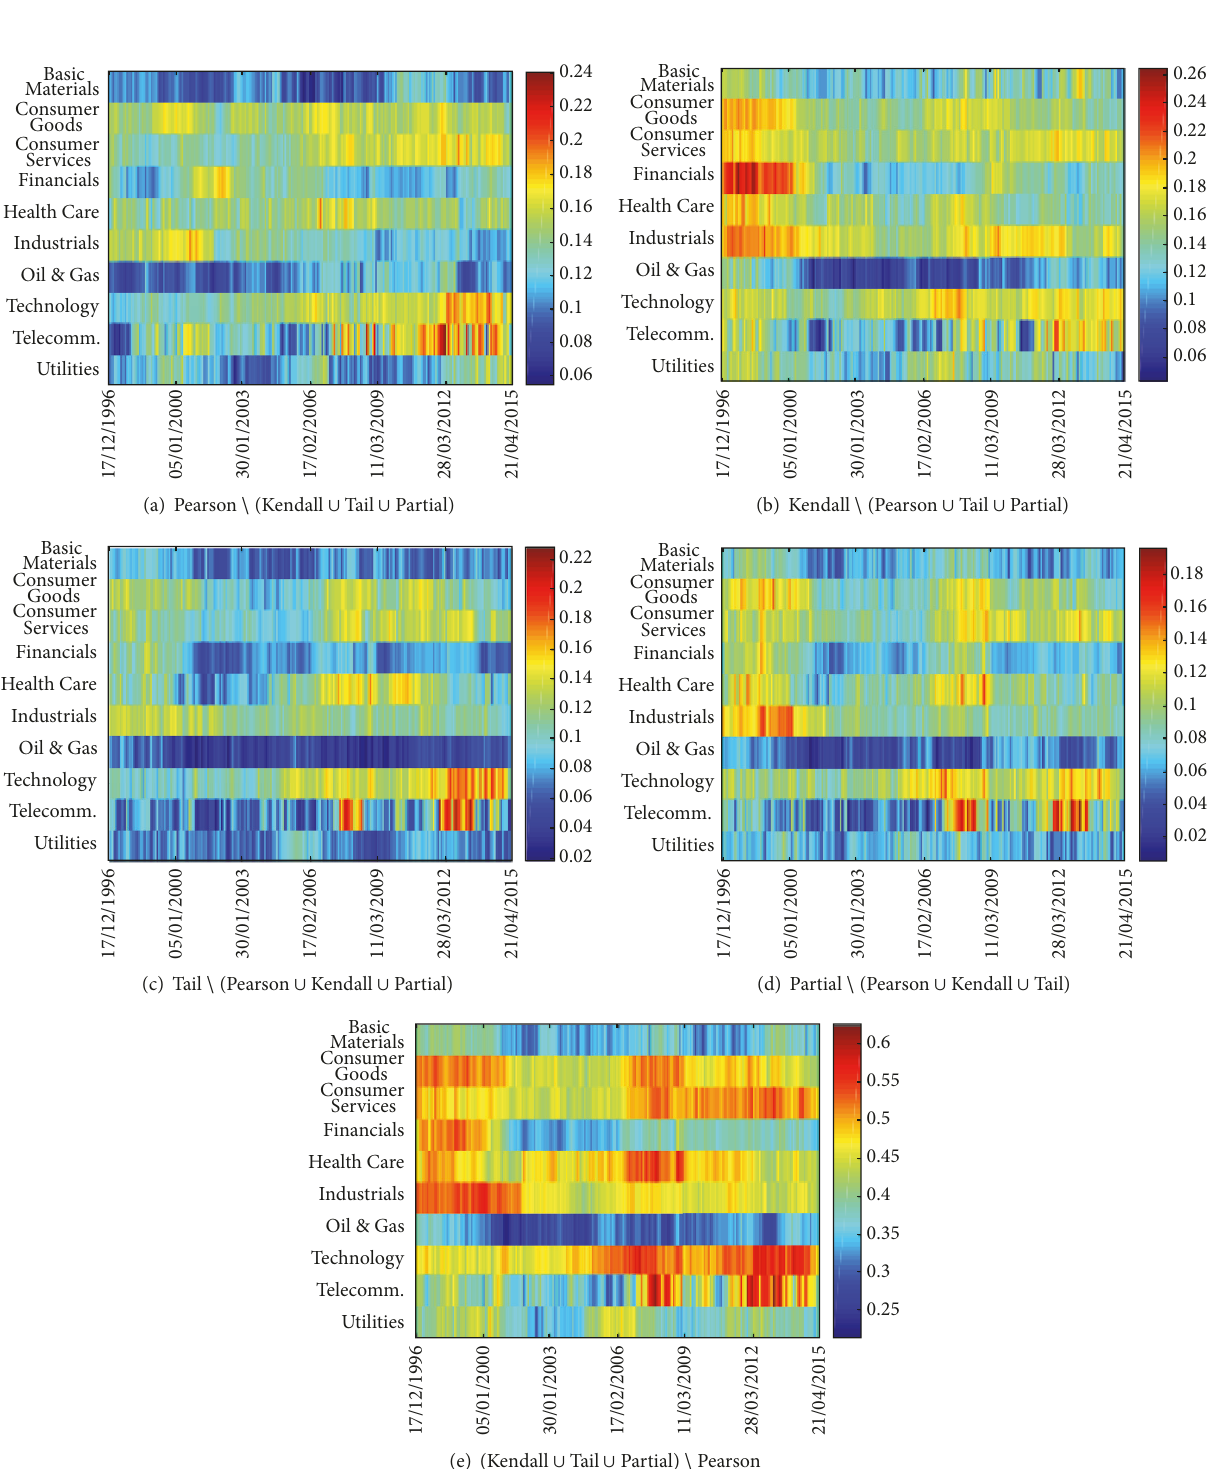
Figure 2: Multidegrees reveal the different role of industrial sectors during crises. The plots of the average multidegree of the nodes of the same industrial sector restricted to edges existing exclusively on the (a) Pearson, (b) Kendall, (c) Tail, and (d) Partial layers clearly show that some dependence measures can reveal structures which are unnoticed by other measures. In particular, the plot of the average multidegree associated with edges existing on at least one layer among Kendall, Tail, and Partial, but not on Pearson (panel (e)), reveals that Pearson correlation does not capture many important features such as the prominent role of Basic Materials, Financial, Consumer Goods, and Industrials during crises and the increasing importance of Technology and Consumer Services after the 2007-2008